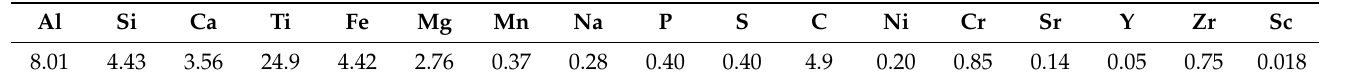
Table 8. Chemical composition of the titanium concentrate prepared by leaching of the acid residue, wt.%.